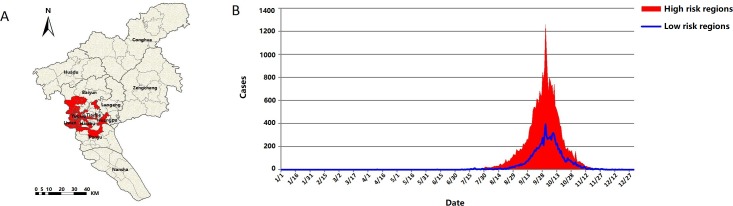
The spatial distributions of high and low DF risk streets and the counts of daily indigenous DF cases in high and low risk streets.Fig 4A was generated by ArcGIS 10.0 (Environmental Systems Research Institute, RedLands, California, U.S.A). (A) High risk streets with RRs>1 and low risk streets with RRs≤1. (B) The epidemic pattern of daily accumulative dengue cases in high-risk clustering streets and the low-risk clustering streets in Guangzhou city, 2006–2014.